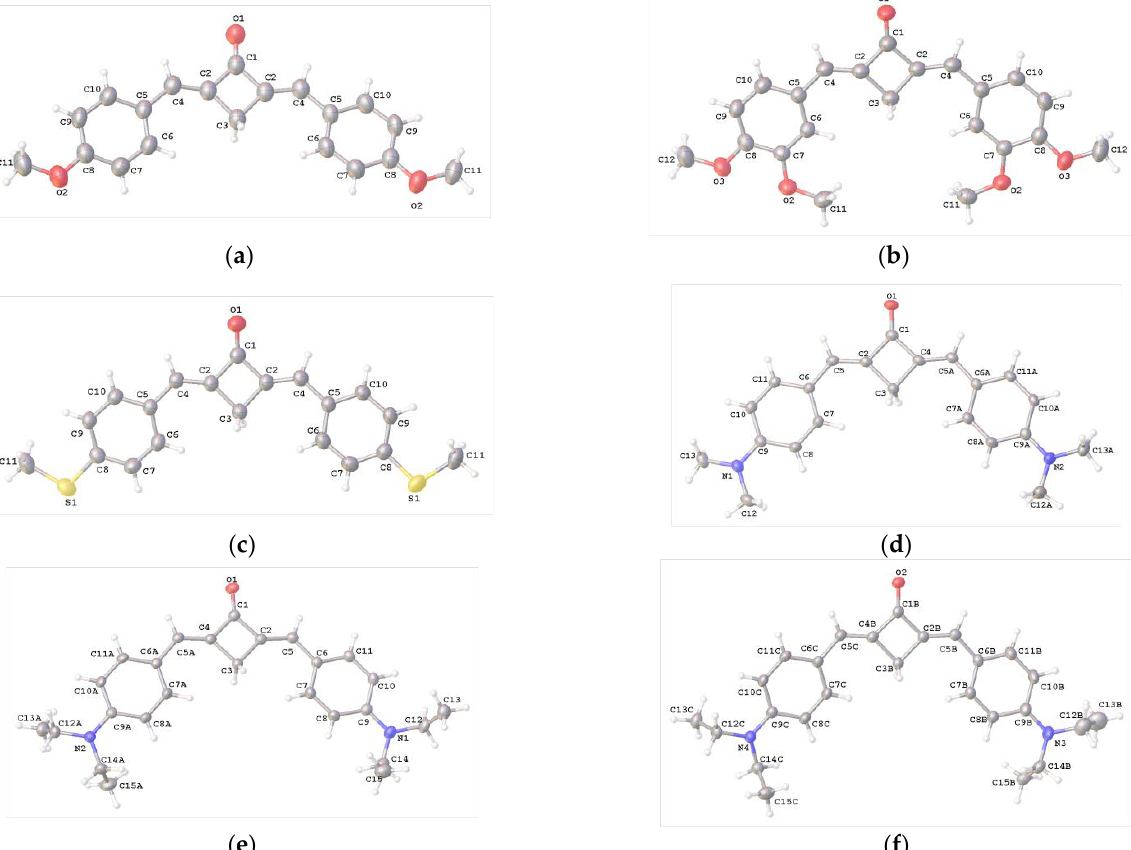
Figure 2. Molecular structure and atom numbering in crystals 1b ( a ), 1c ( b ), 1d ( c ), 1e ( d ) and two independent units 1f ( e , f ).